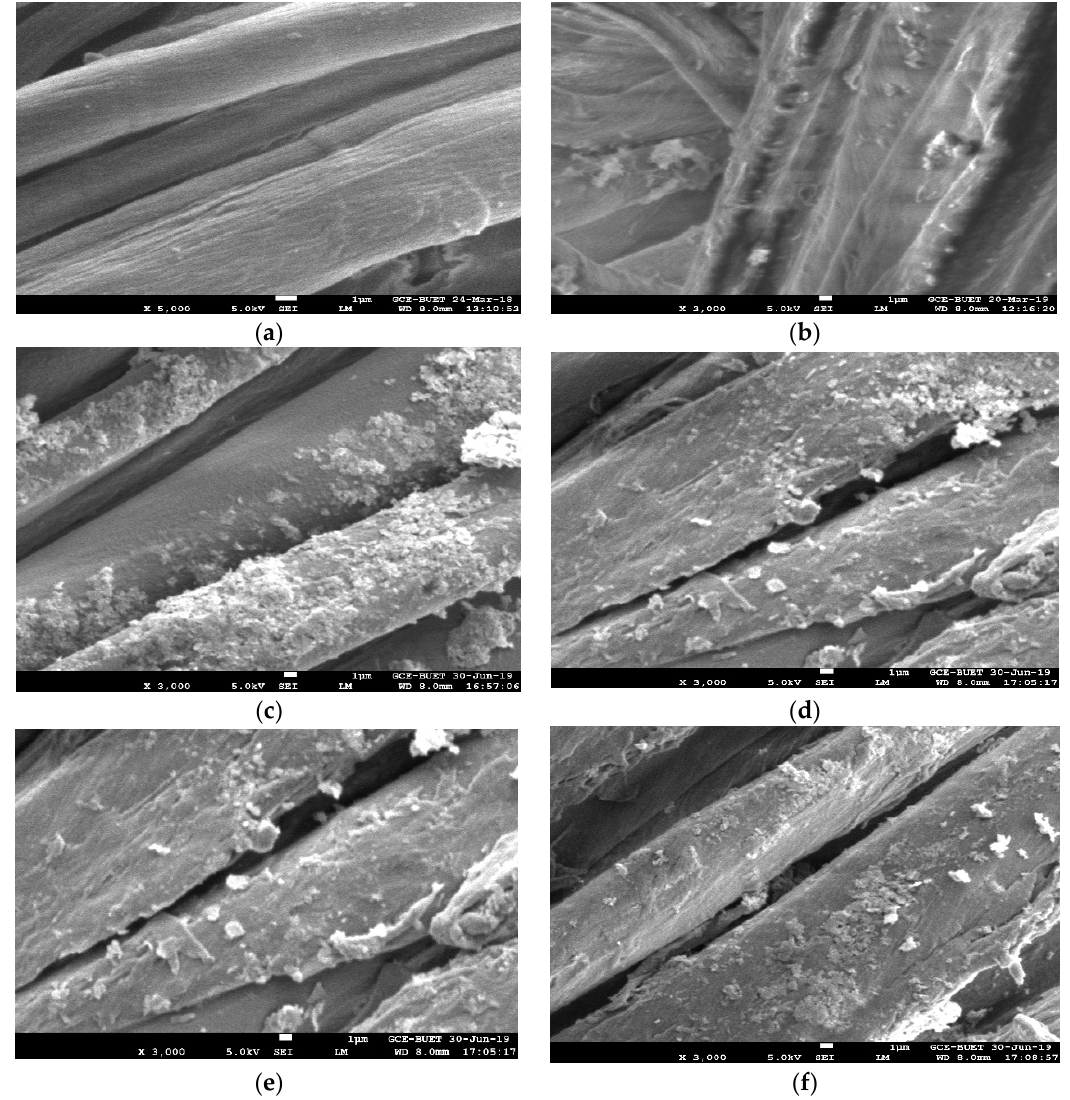
Figure 8. SEM images of different samples: ( a ) untreated fabric, ( b ) NanoZnO-1, ( c ) NanoZnO-2, ( d ) NanoZnO-3, ( e ) NanoZnO-2 after washing, and ( f ) NanoZnO-3 after washing.